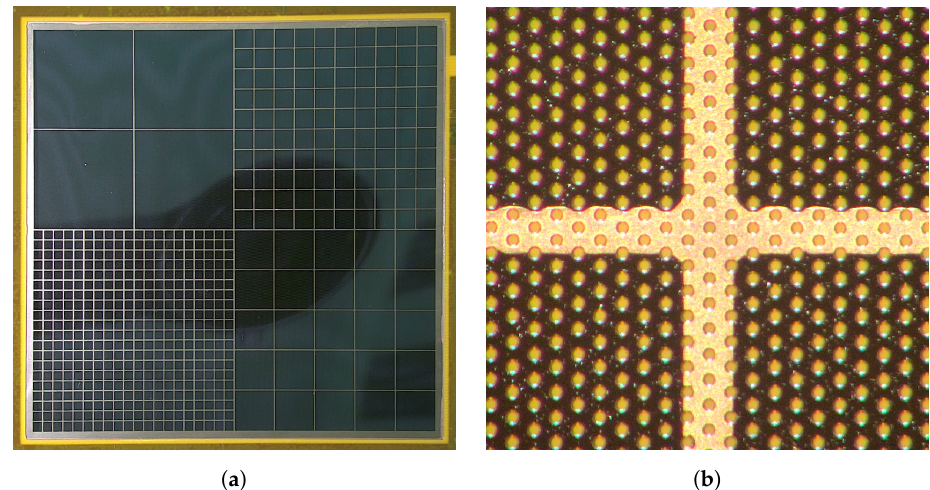
Figure 2. Pictures of the copper-less foils. ( a ) A photograph of copper-less GEM foil with different copper grid layouts; ( b ) A micro-photograph of the copper grid stripe (250µm